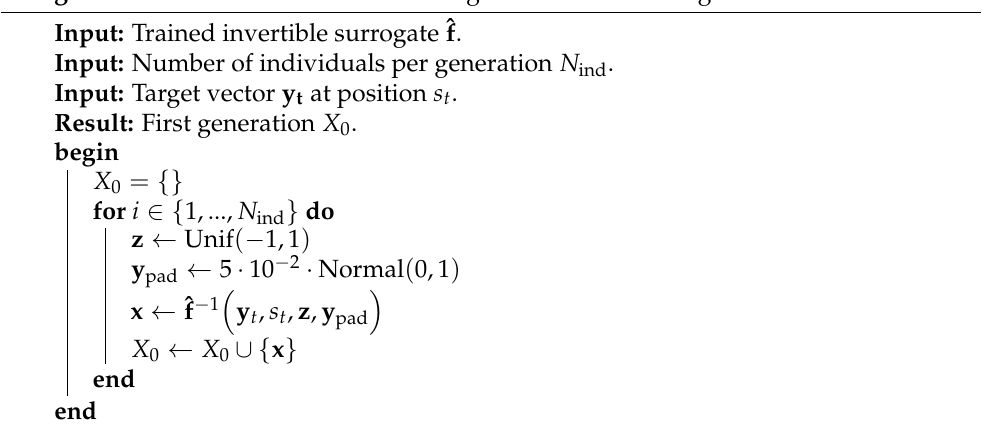
Algorithm A2: Biased initialisation using the invertible surrogate